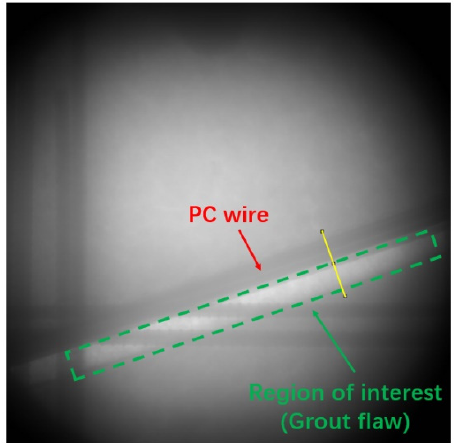
Figure 18. X-ray Image acquired from 200 mm thick WEB of the T-shape PC girder bridge and explanation of the inner structure.